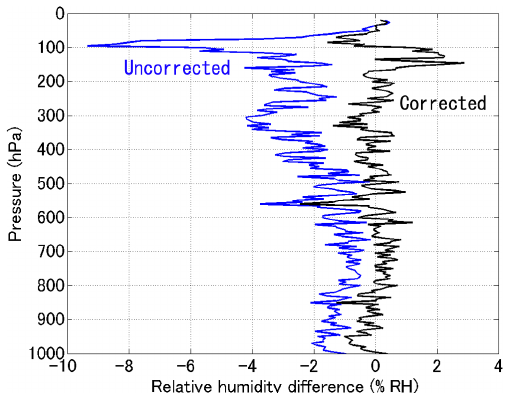
Figure 12. Medians of the relative humidity difference between the RS92 and RS41 radiosondes obtained during the daytime on the MR15-04 cruise. Blue and black lines show the profiles before and after the bias correction of the RS92 data.